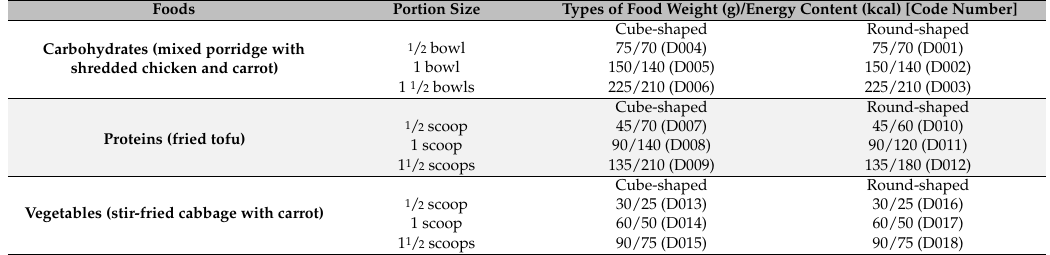
Figure 5. Food models for foodscapes preferences—shape criterion (for vegetables). Table 3. Portion size of different shapes of foods with corresponding weight and energy content.